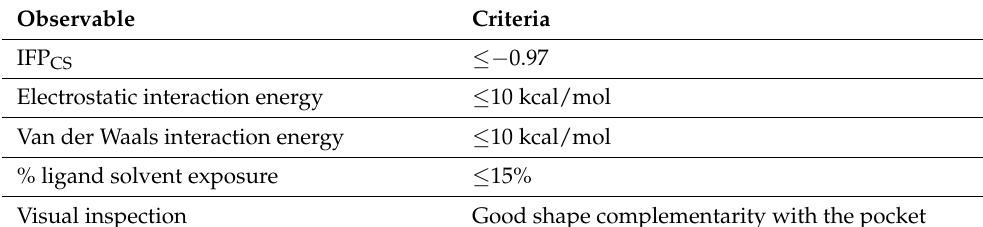
Table 2. A heatmap reporting a per-residue decomposition of the electrostatic (kcal/mol) and hydrophobic (arbitrary units) contribution to the protein–ligand interaction energy for selected poses was generated by making use of an in-house SVL script. Table 2. Pose filtering criteria adopted for the docking-based virtual screening performed on the I7L protease dimeric